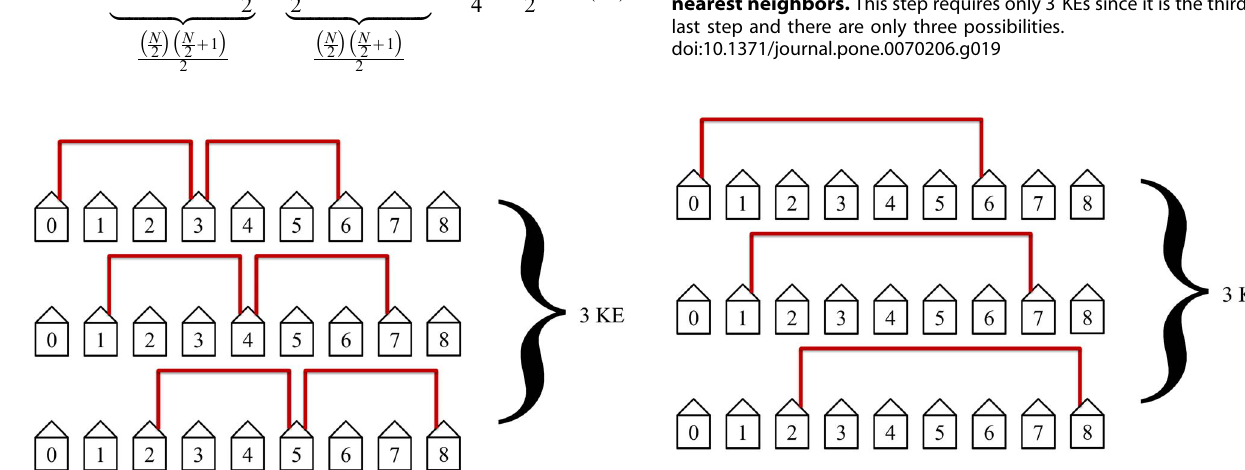
Figure 17. The fourth step in the protocol connects the fourth nearest neighbors. It requires 4 KEs to complete.